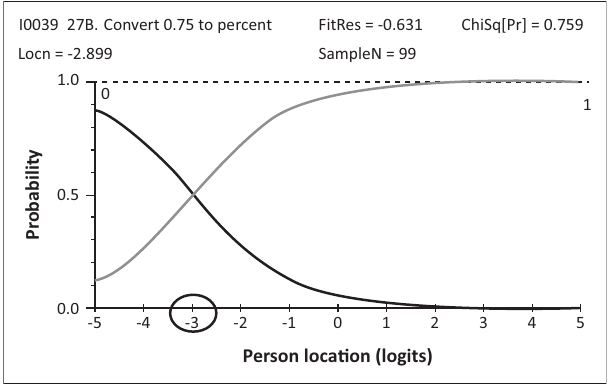
FIGURE 3: Item 58 – difficult category probability curve.